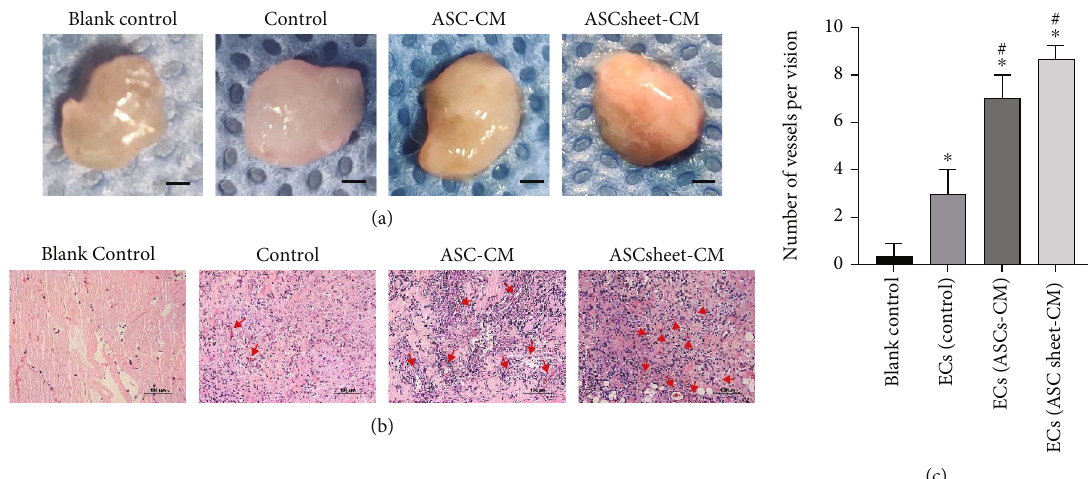
Figure 10: Angiogenic e ff ects of ASC-CM and ASC sheet-CM in Matrigel plug assay in vivo. (a) Macroscopic view of representative explants at 3 weeks. Matrigel plug containing ECs treated with di ff erent media was subcutaneously injected into the dorsum of rats. The explants were excavated after 3 weeks. The group of Matrigel plugs without ECs was used as the control. (b) New vascular formation of the explant sections was detected by H&E staining; red arrows indicate blood vessels. Scale bars: 100 μ m. (c) Statistical analysis of microvessel numbers in Matrigel explants. ∗ p < 0 : 05 , versus the blank control group; # p < 0 : 05 , versus the ECs group (control group).